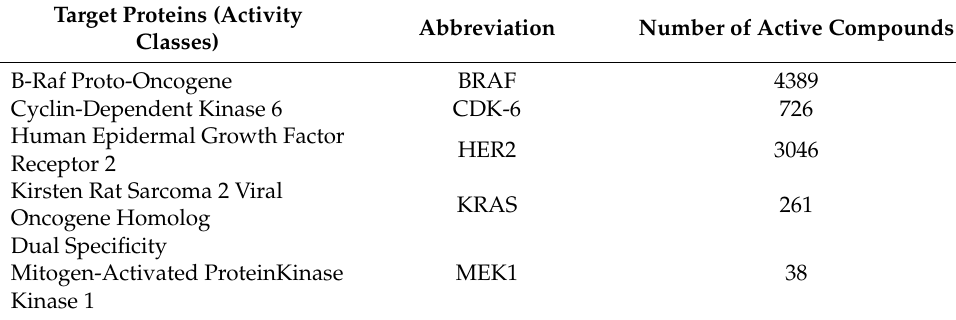
Figure 4. The four main phases of the study: data acquisition, data preprocessing, predictive modelling and performance evaluation. Table 6. Selected Activity